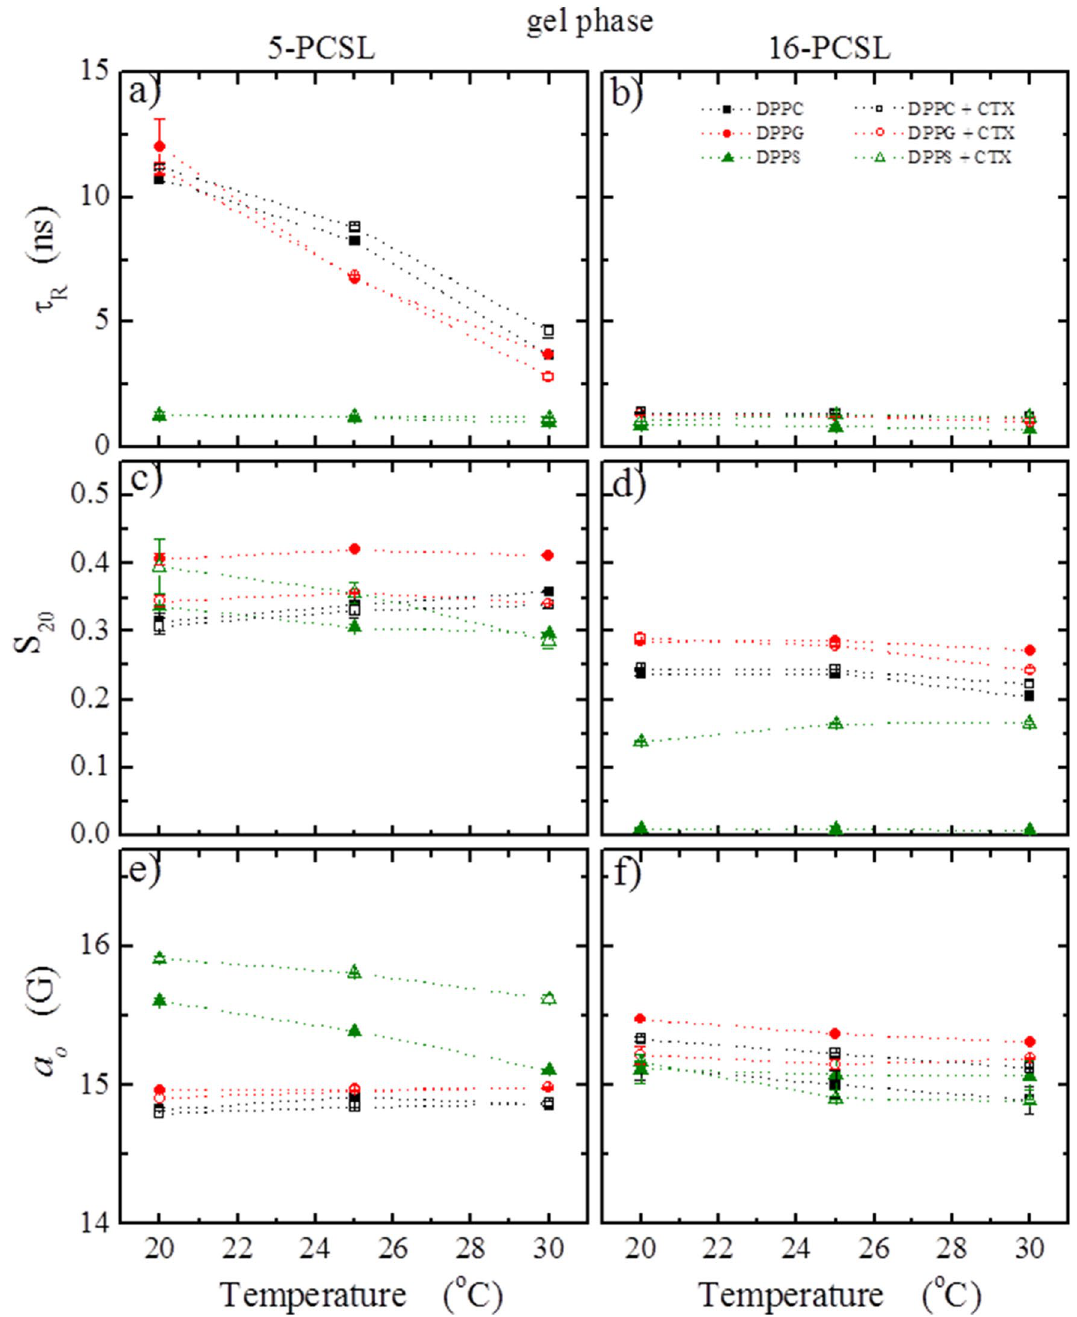
Figure 7. Temperature dependence of the parameters obtained from the best theoretical simulations of the spectra in Fig. 5: ( a and b ) average rotational correlation time τ R , ( c and d ) order parameter S 20 , and ( e and f ) isotropic hyperfine splitting a o . The left and right columns correspond to the parameters obtained from spectra of the spin labels 5- and 16-PCSL, respectively, inserted in pure lipids (solid symbols) and in the mixtures of lipid/protein (open symbols), at the lipids gel